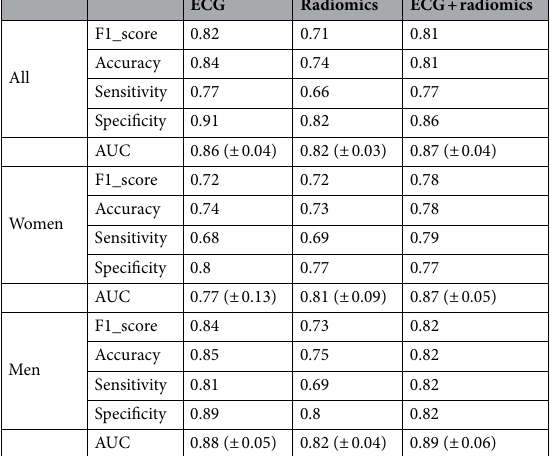
ECG Radiomics ECG + radiomics